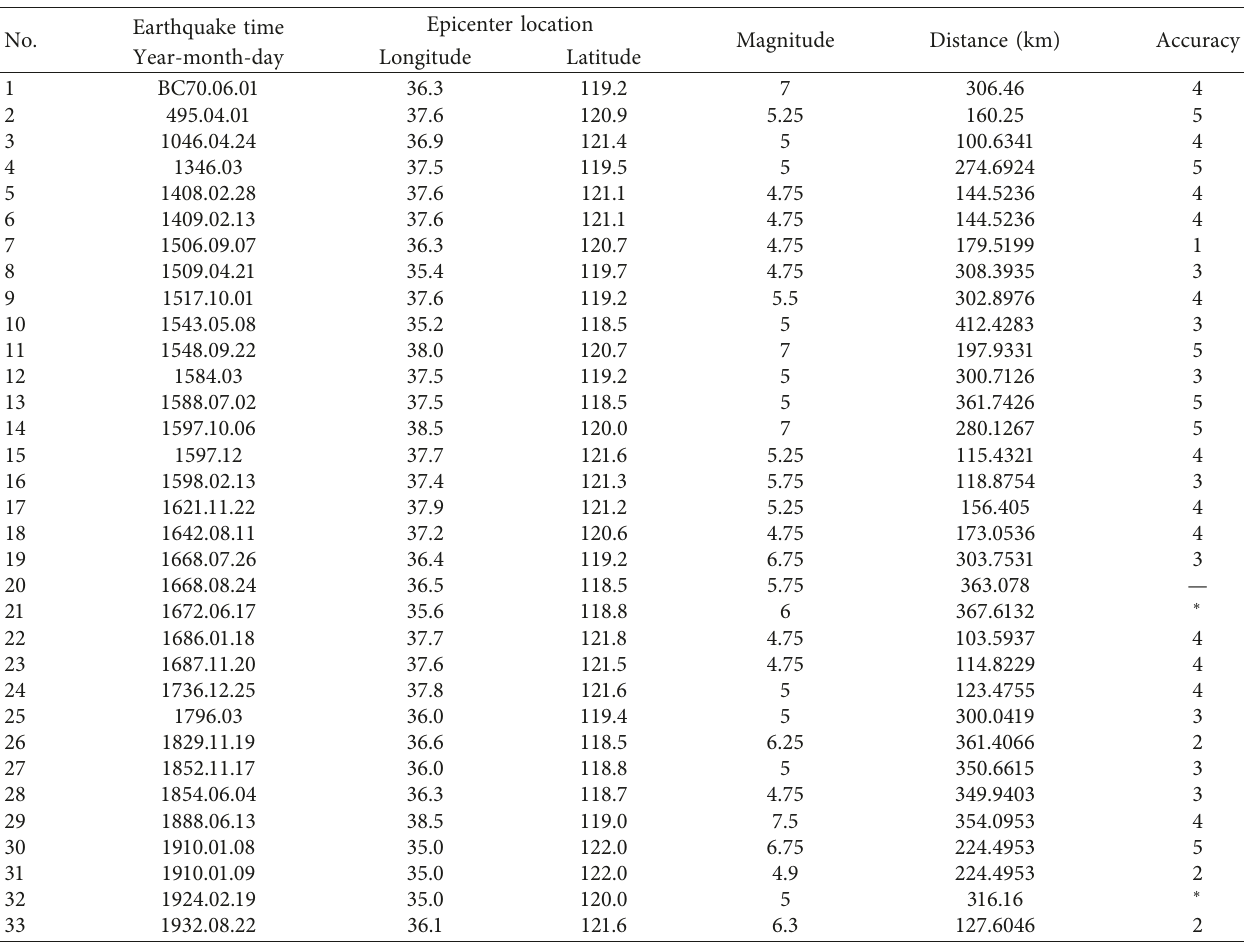
≥ 4 . 7; ∗ represents lack of s